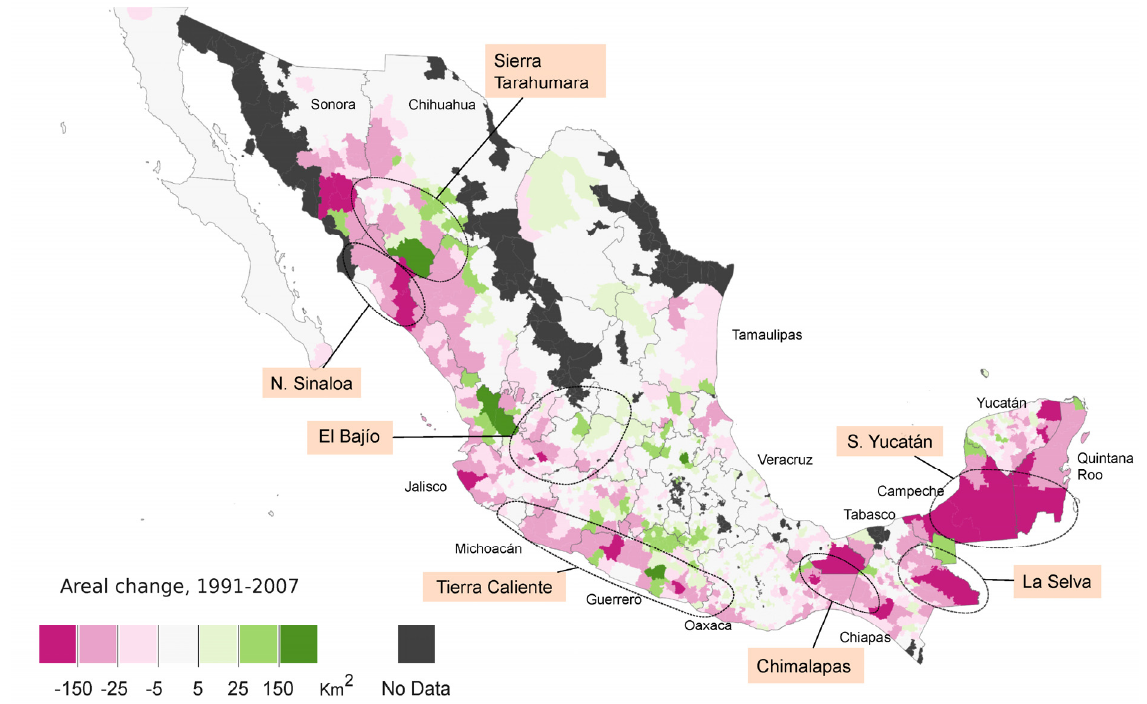
Figure 5. Changes in forest cover 2002–2012. Note that colors and class ranges are the same as in Figure 3, but the color ramp is inverted to show municipios with increasing forest in green and municipios with shrinking forest in pink. Source: Serie II and Serie V